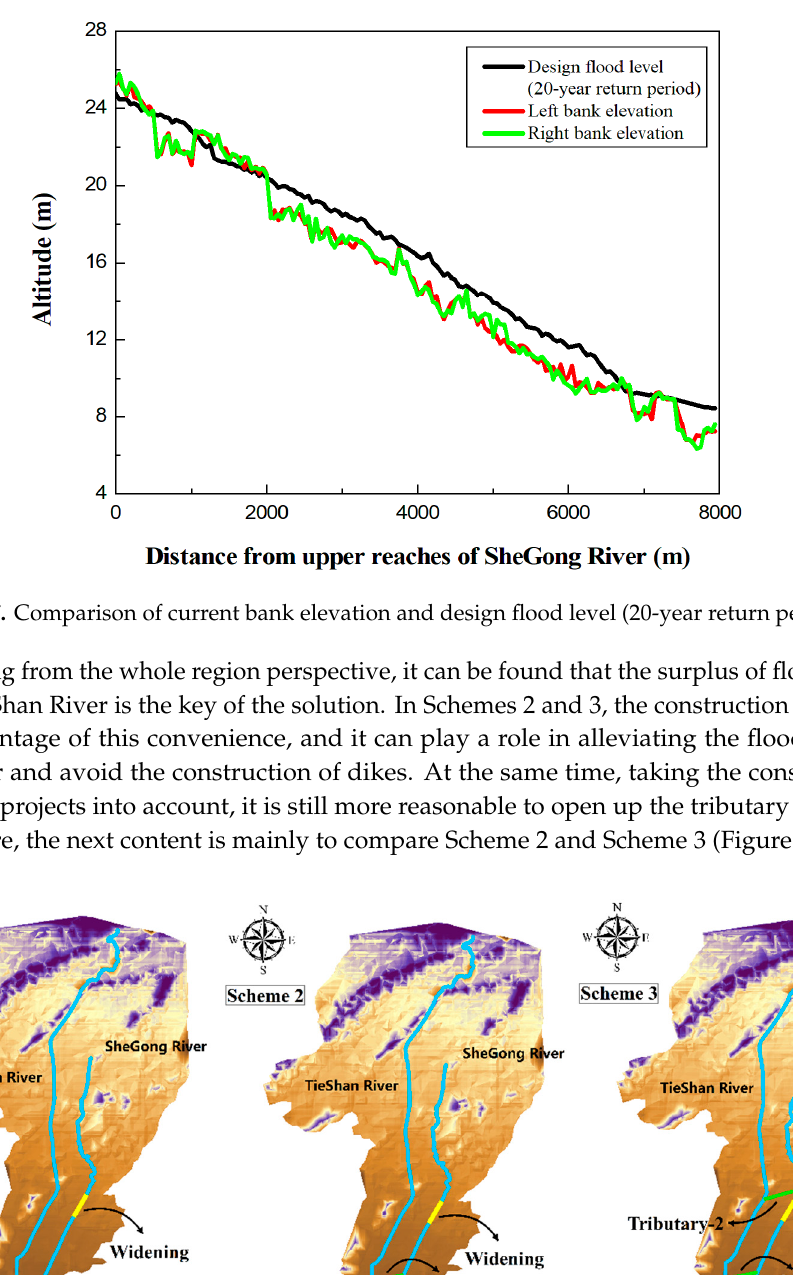
Figure 9. Simulation results of design water surface line. In terms of the cost of land acquisition and house demolition, Scheme 3 is lower than Scheme 2. When looking into the water level reduction effect, Scheme 2 has a better reduction effect at the culvert, but Scheme 3 has a better reduction effect in the downstream area. Considering that the downstream area has a higher grade in the development planning, the final regulation scheme is to